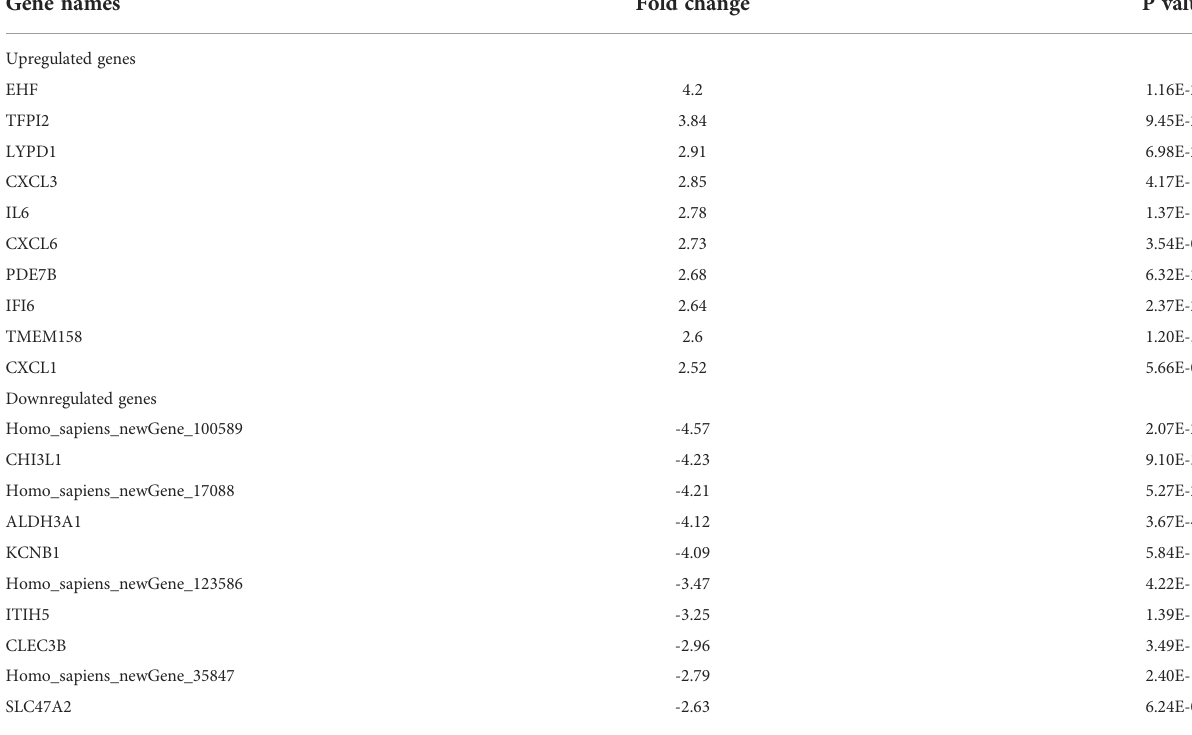
TABLE 2 The top 10 upregulated and downregulated genes in M2CM treated NPCs. Gene names Fold change P